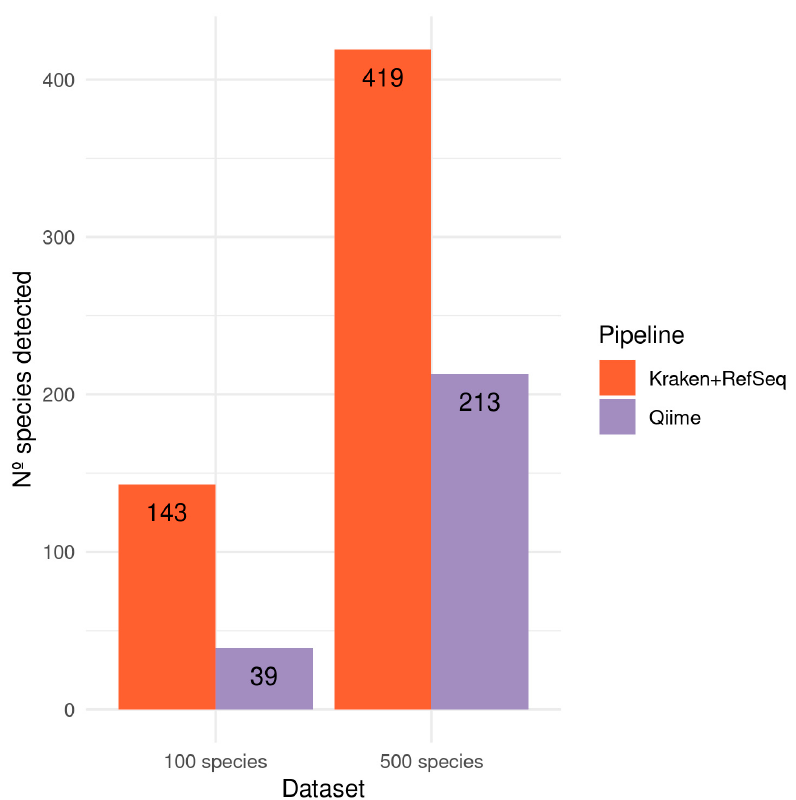
Figure 10. Number of species identified by Kraken/Bracken pipeline and QIIME2. Barplot show- ing the number of microorganisms species detected by Kraken/Bracken pipeline (using RefSeq da- tabase) and QIIME2 in gut data from Almeida and collaborators.